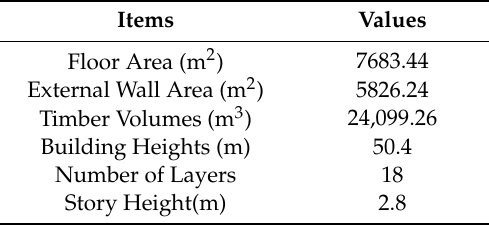
Table 4. Building information.